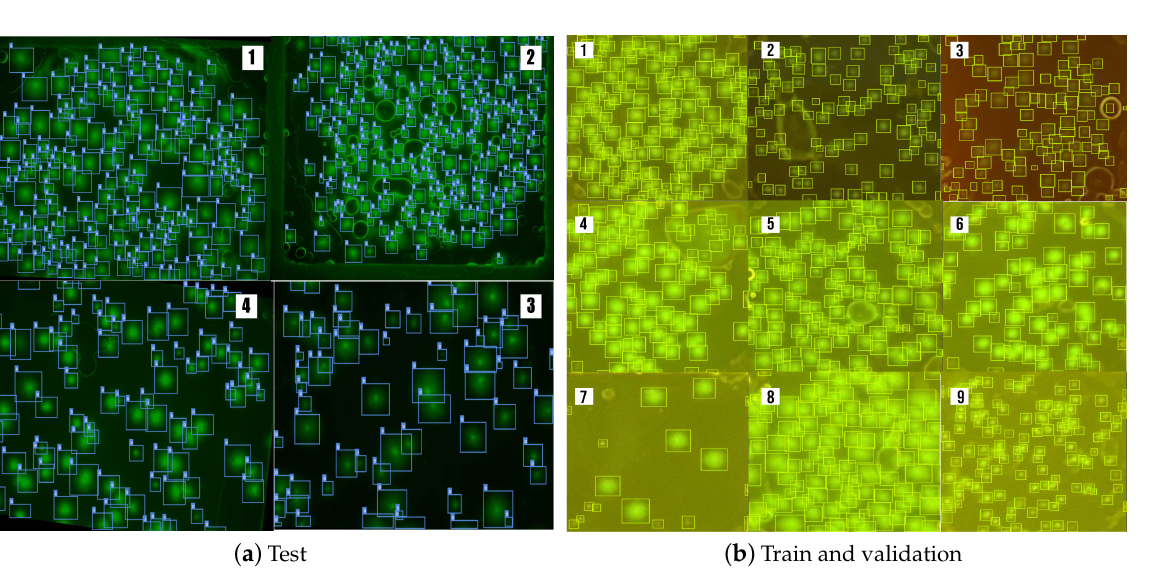
Figure 11. ( a ) Examples of green fluorescent cell images that have been captured from the Leica DMi8 fluorescence microscope and meticulously annotated. ( b ) Examples of green fluorescent cell images that have been captured from mgLAMP using a smart phone camera and meticulously annotated by